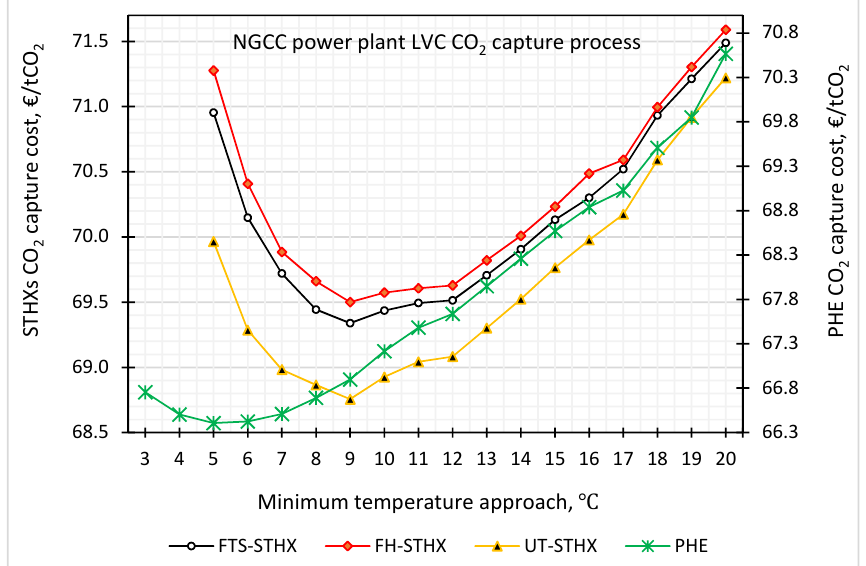
Figure 8. Energy and heat exchanger costs trade-off analysis at different ∆ T min for different heat exchanger types in an LVC CO 2 capture from NGCC power plant exhaust gas.